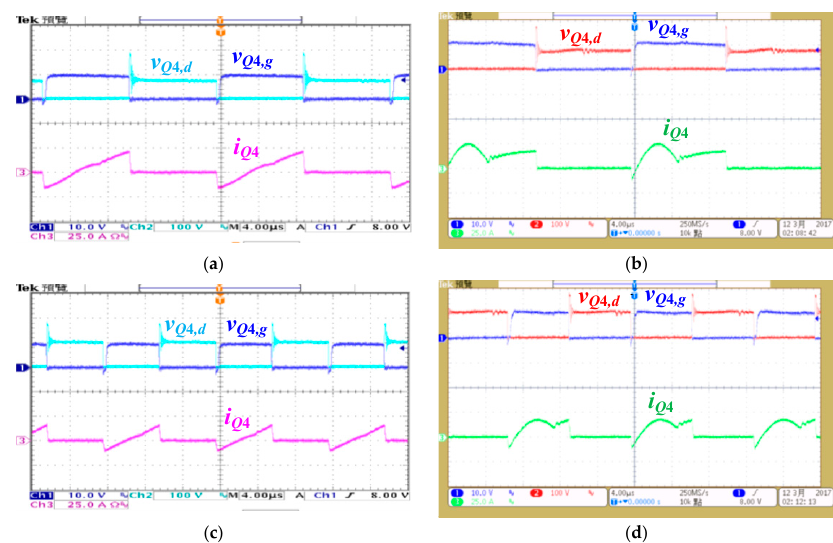
Figure 14. Test results of the power device Q 4 under backward power transfer ( a ) V L = 38 V and 20% load ( b ) V L = 38 V and 100% load ( c ) V L = 52 V and 20% load ( d ) V L = 52 V and 100% load [ v Q 4 ,g : 10 V/div; v Q 4 ,d : 100 V; i Q 4 : 25 A/div; time: 4 µs/div].